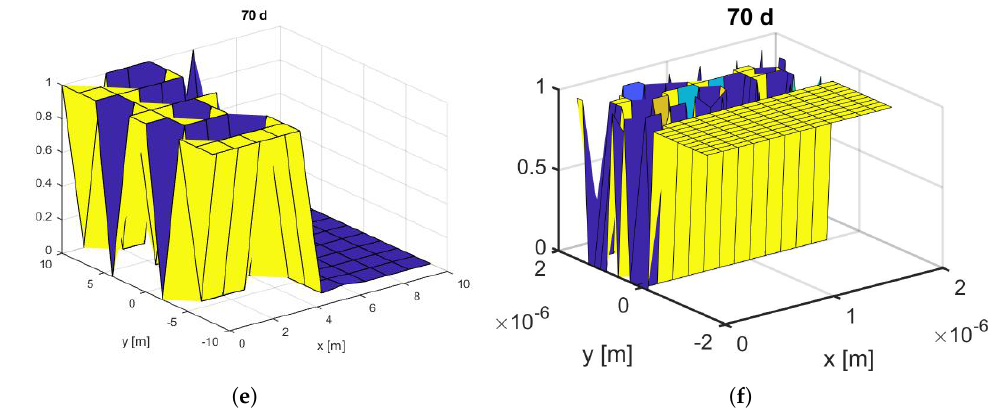
Figure 11. Concentration distribution of tracers at Darcy’s scale within the porous media in ( a , c , e ) Akanji and Falade 2019 [16] while ( b , d , f ) shows the result obtained from this pore-scale computation approach of concentration distribution within the porous media with linear drift ratio d = 0.2 and time interval t = 10 d, 50 d, and 70